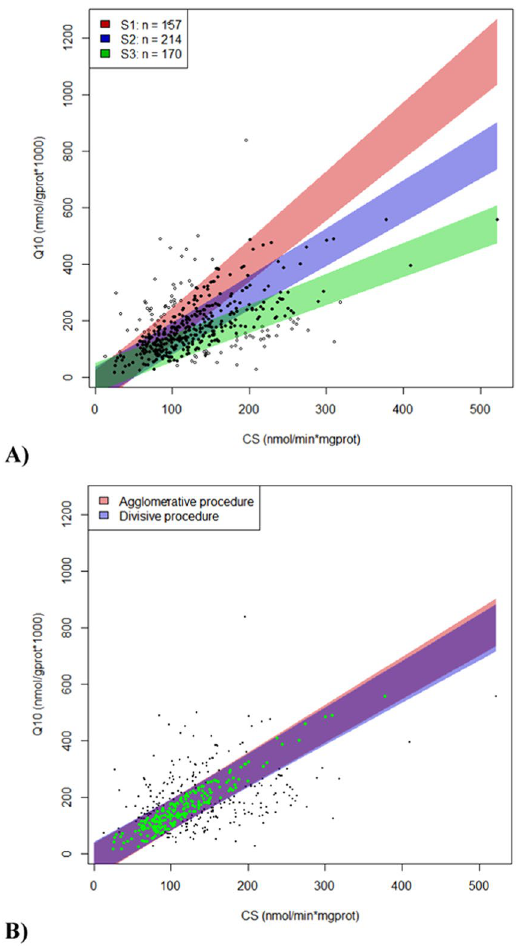
Figure 1. Statistical study between muscle CS activity and CoQ values. ( A ) Three possible clusters identified by the agglomerative method. The cluster selected was the one with the highest number of individuals (blue). ( B ) Good agreement was observed between agglomerative and divisive methods.